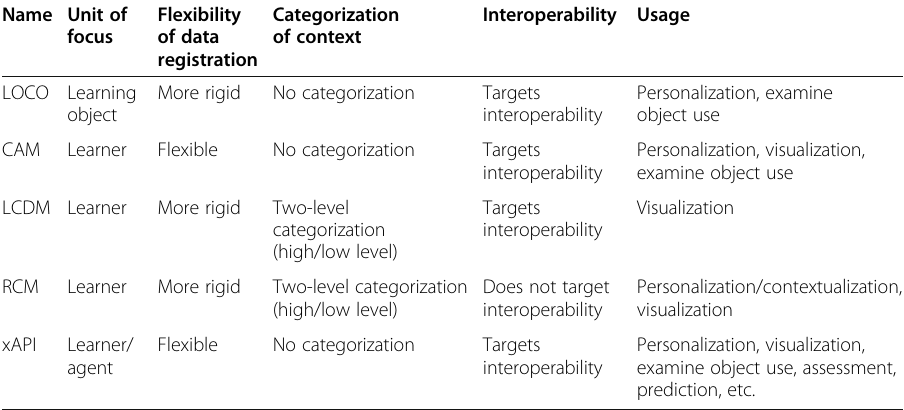
Table 2 Context data model and xAPI comparison Name Unit of